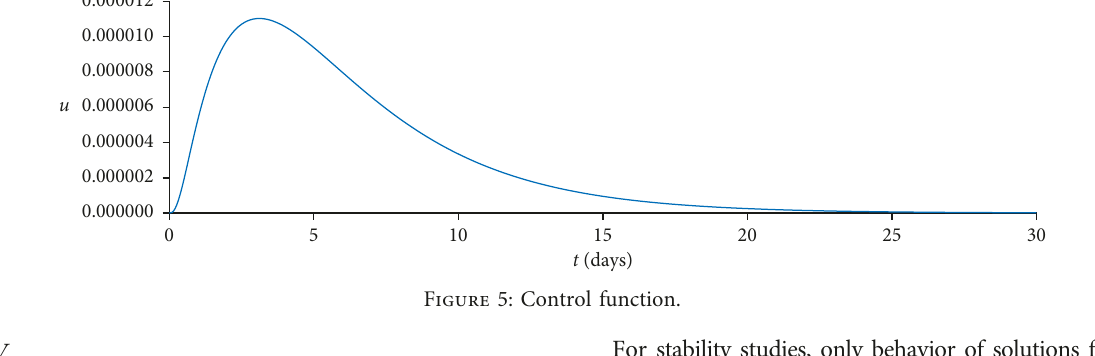
Figure 5: Control